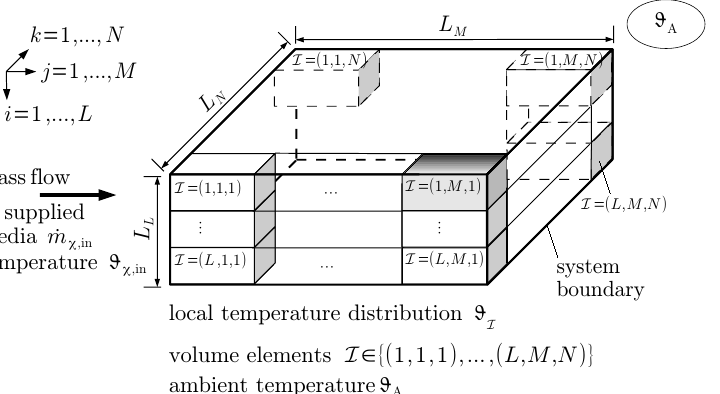
Figure 1. Spatial semi-discretization of the fuel cell stack module (arrangement of finitely large volume elements in up to three space coordinates) [16]. Table 1. Variables of the solid oxide fuel cell (SOFC) model.